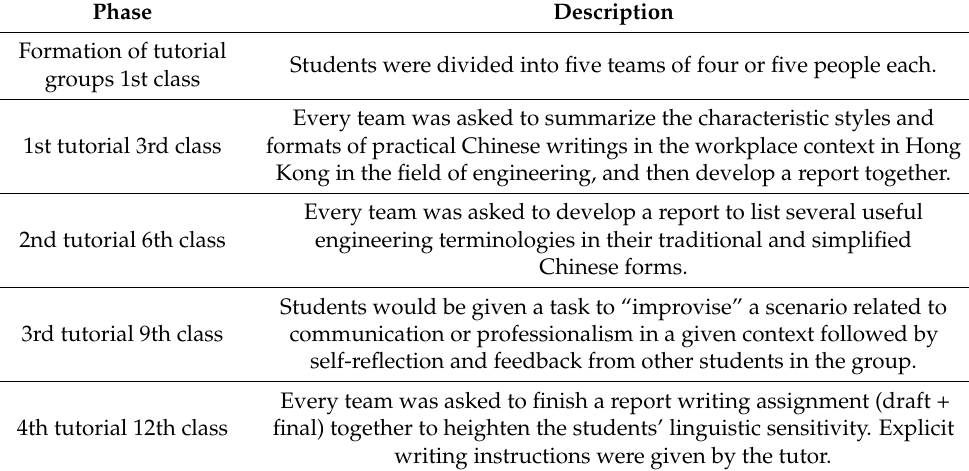
Table 2. The tutorial designed for the experimental